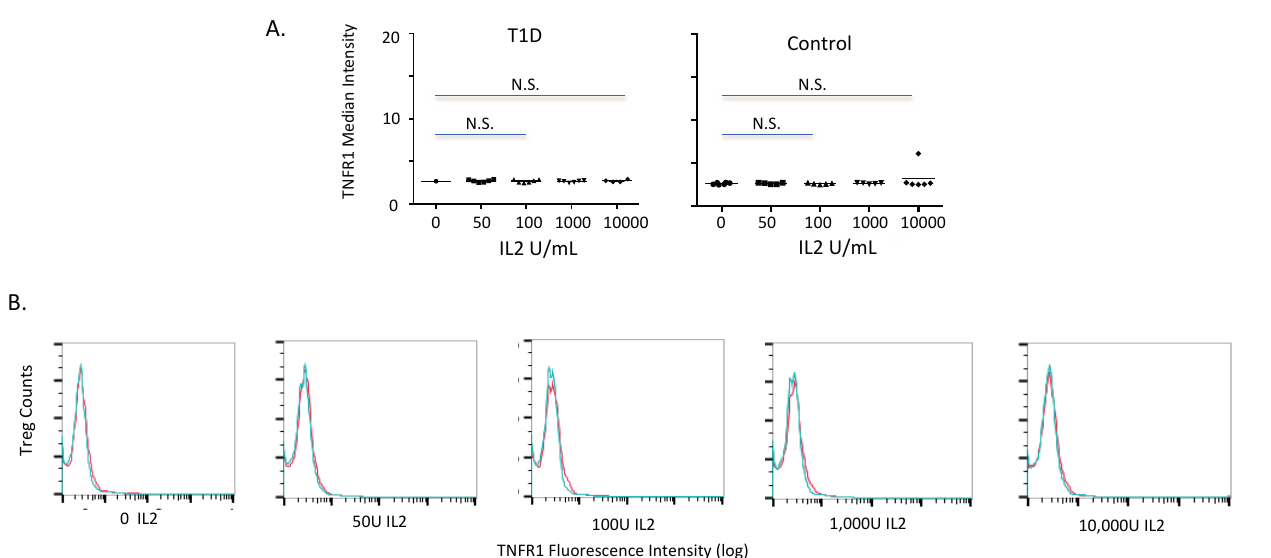
Figure 2. Treatment of freshly isolated human Tregs with escalating IL2 doses (24 h) to study the possible induction of TNFR1 in a comparison of type 1 diabetic (T1D) versus control subjects. ( A ) The median fluorescence intensity of TNFR1 on isolated CD4 T cells stained for Treg; a dose comparison for TNFR1 of type 1 diabetic (n = 6) to control (n = 6) subjects with IL2. No induction of TNFR1 occurs with escalating IL2 doses in either the diabetic or the control Treg cells. ( B ) IL2 dose response of TNFR1 induction on curves of Treg cells of a single type 1 diabetic (blue) compared to a single control (red) at each IL2 dose from 0–10,000 U/mL for 24 h. This data assessed the total number of Treg cells expressing TNFR1 with and without IL2. Neither the diabetic nor the control subject Treg cells expressed more TNFR1 with IL2